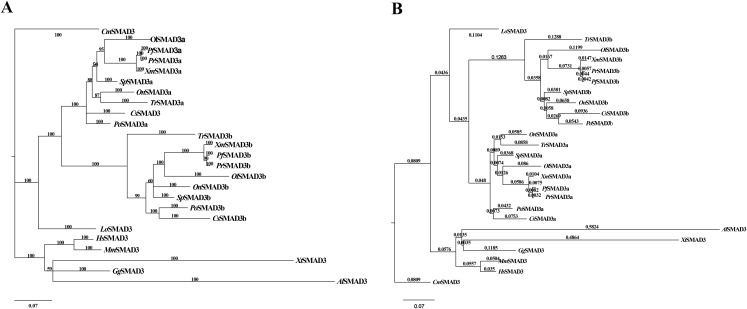
Phylogenetic analyses of SMAD3.(A) Phylogenetic tree constructed by Bayesian method with GTR+I+G, MCMC = 300,000. Elephant shark SMAD3 was used as the outgroup. Numbers at the nodes are posterior probabilities. (B) Phylogenetic tree constructed by phyML with GTR+I+G. Elephant shark SMAD3 was used as the outgroup. Numbers at the nodes are bootstrap values with 1,000 replicates. Cm, Callorhinchus milii; Lo, Lepisosteus oculatus; Tr, Takifugu rubripes; Ol, Oryzias latipes; Xm, Xiphophorus maculatus; Pr, Poecilia reticulata; Pf, Poecilia formosa; Sp, Stegastes partitus; On, Oreochromis niloticus; Cs, Cynoglossus semilaevis; Po, Paralichthys olivaceus; Al, Anolis carolinensis; Xt, Xenopus tropicalis; Gg, Gallus; Mm, Mus musculus; Hs, Homo sapiens.